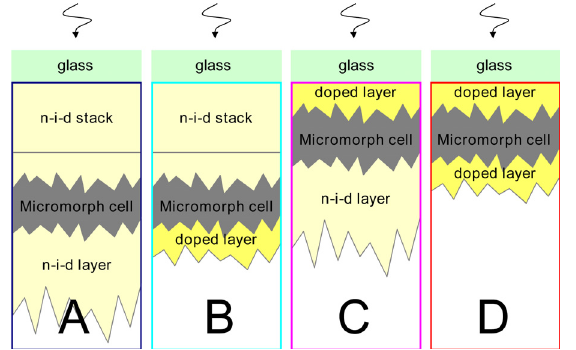
Fig. 1. Schematic view of the stacks composing the A, B, C and D micromorph devices. Only the front and back electrodes are changed. Light enters the devices from the top.